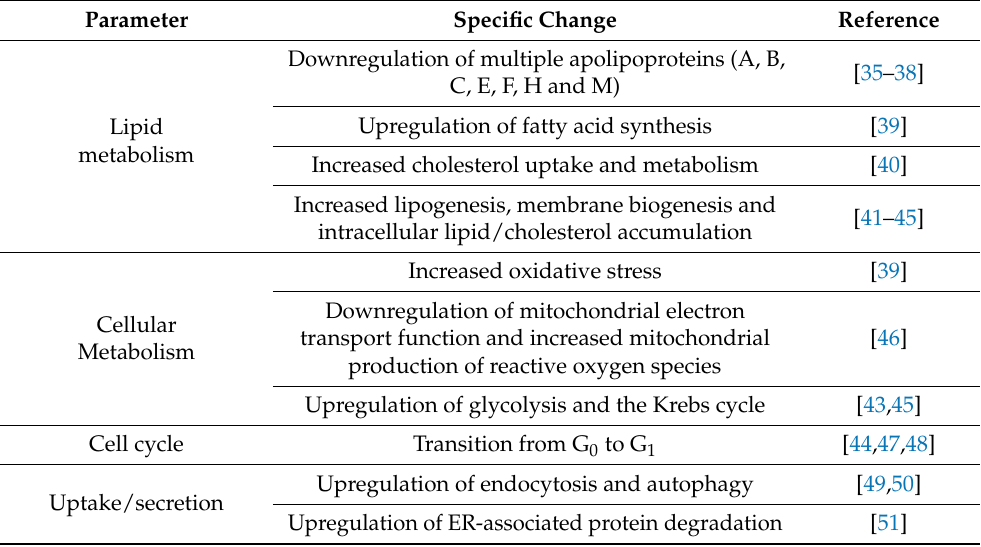
Table 1. Impact of HBV infection on hepatocyte